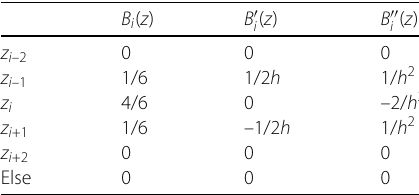
Table 1 Values of B i ( z ), B (cid:3)